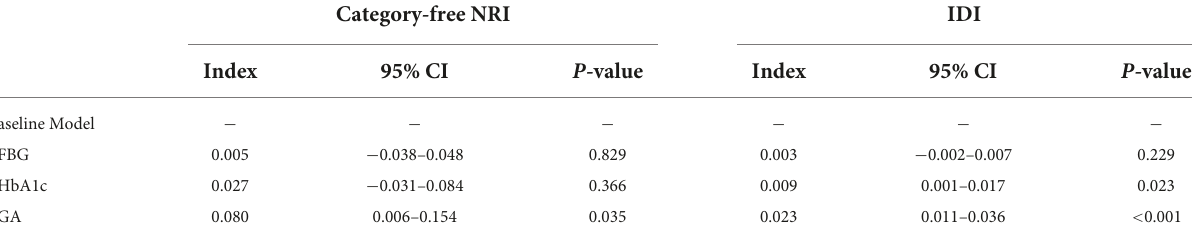
TABLE 6 Category-free NRI and IDI for the incremental predictive values of various